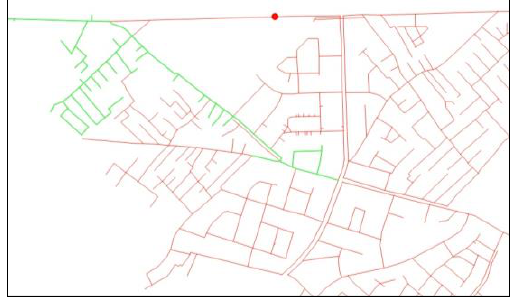
Figure 3. Water pipeline failure and affected areas